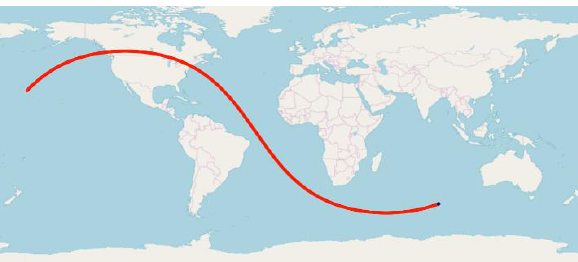
Figure 2: Real-time International Space Station (ISS) Ground Track. Black dot displays the current location while the red line shows its trajectory path.